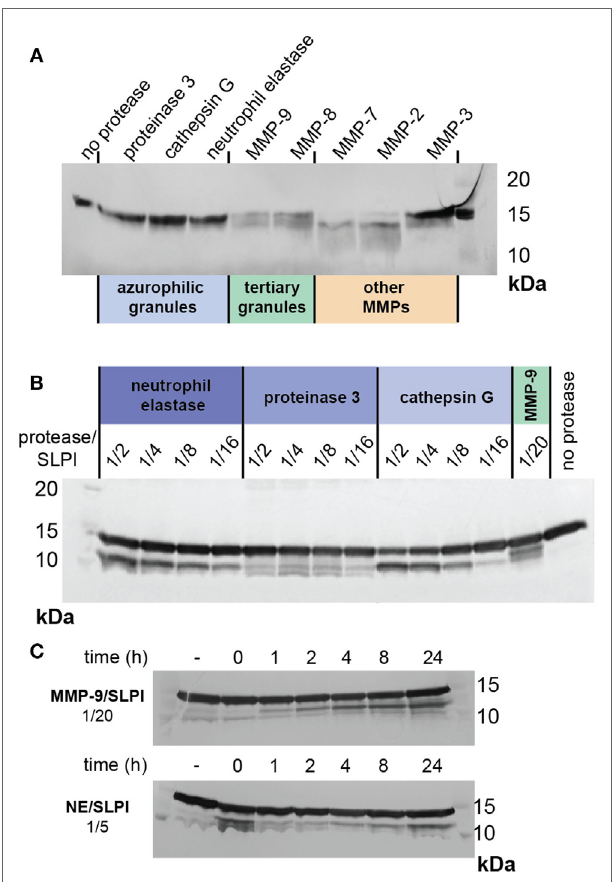
FigUre 6 | Cleavage of secretory leukocyte peptidase inhibitor (SLPI) by neutrophil proteases and MMPs. (a) SDS-PAGE analysis of SLPI